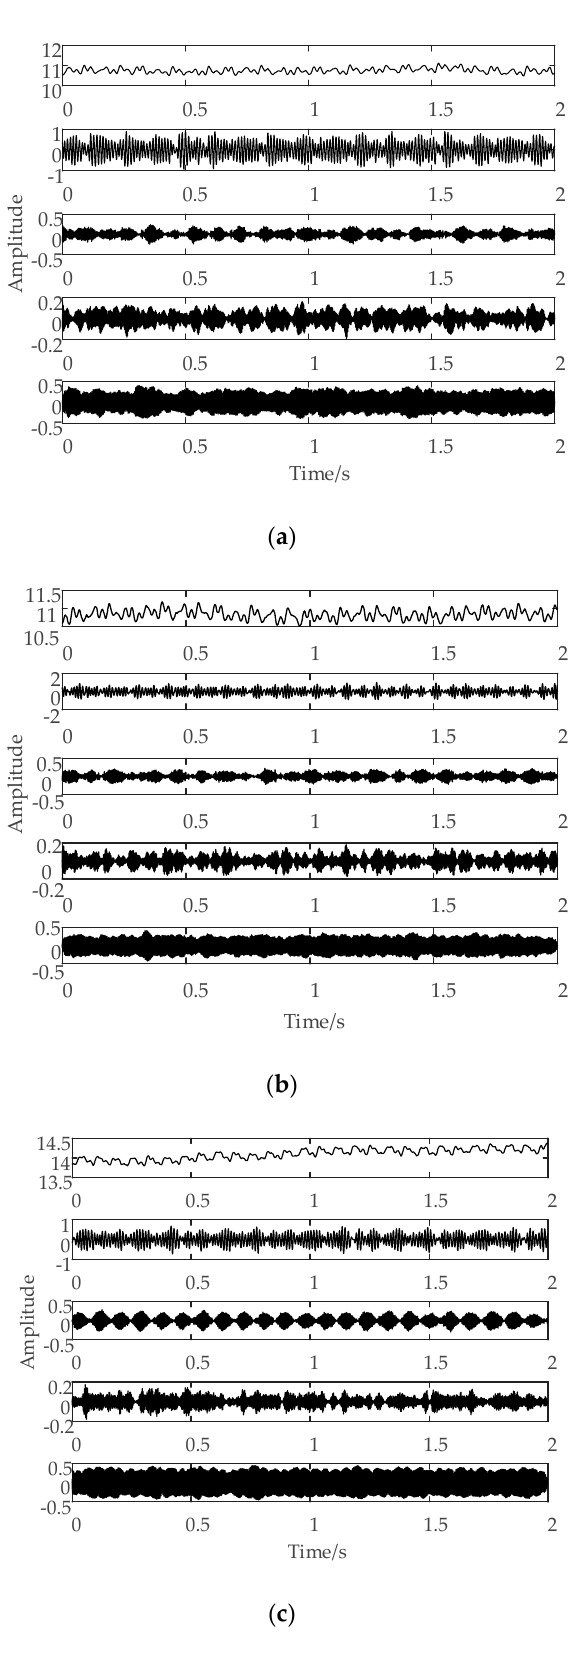
Figure 6. ( a ) The VMD result of the current signal at the initial tool wear stage, ( b ) the normal tool wear stage, and ( c ) the sharp tool wear stage.